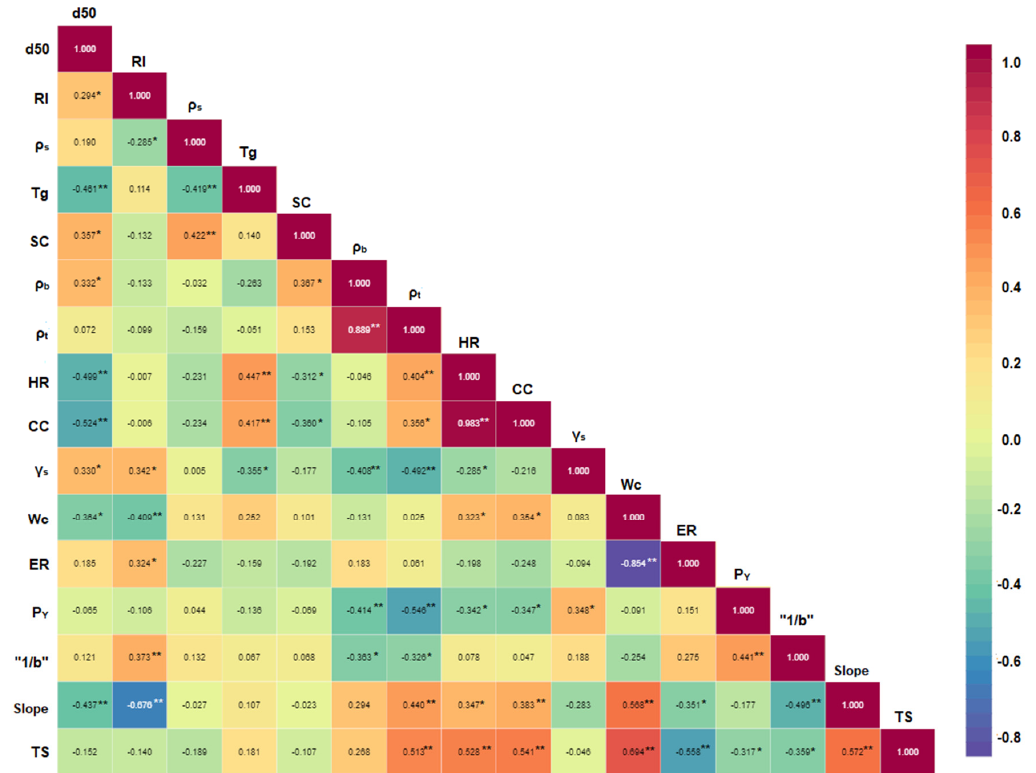
Figure 6. Heat map of Pearson’s correlation coefficient between the studied variables (* Correlation significant at p = 0.05; ** Correlation significant at p = 0.001).